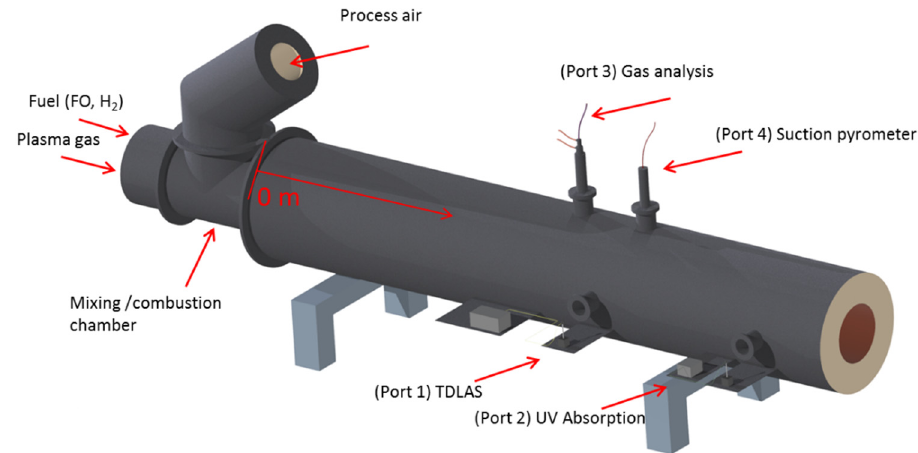
Figure 1. Schematic of the pilot-scale experimental system. Description of the apparatus/techniques used in Ports 1–4 is given in Section 2.2. The origin of the x-axis characterizes the location from which the distances to the optical ports are calculated.